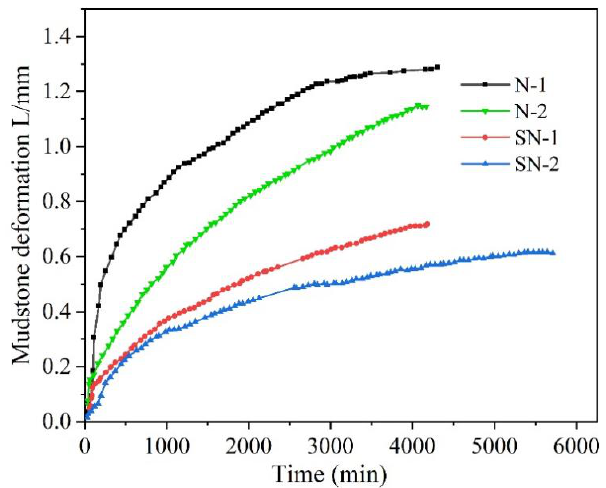
Figure 10. Curve of mudstone deformation with time during water absorption.